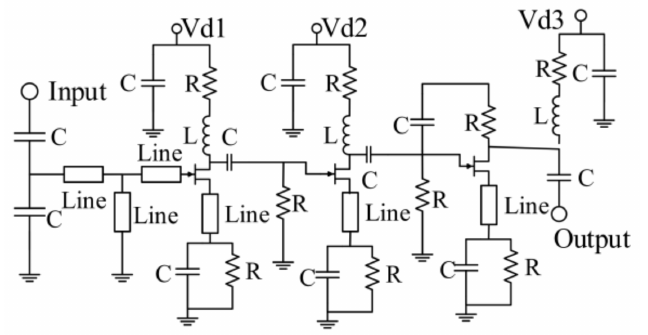
Figure 7. Simplified schematic diagram of the designed three-stage